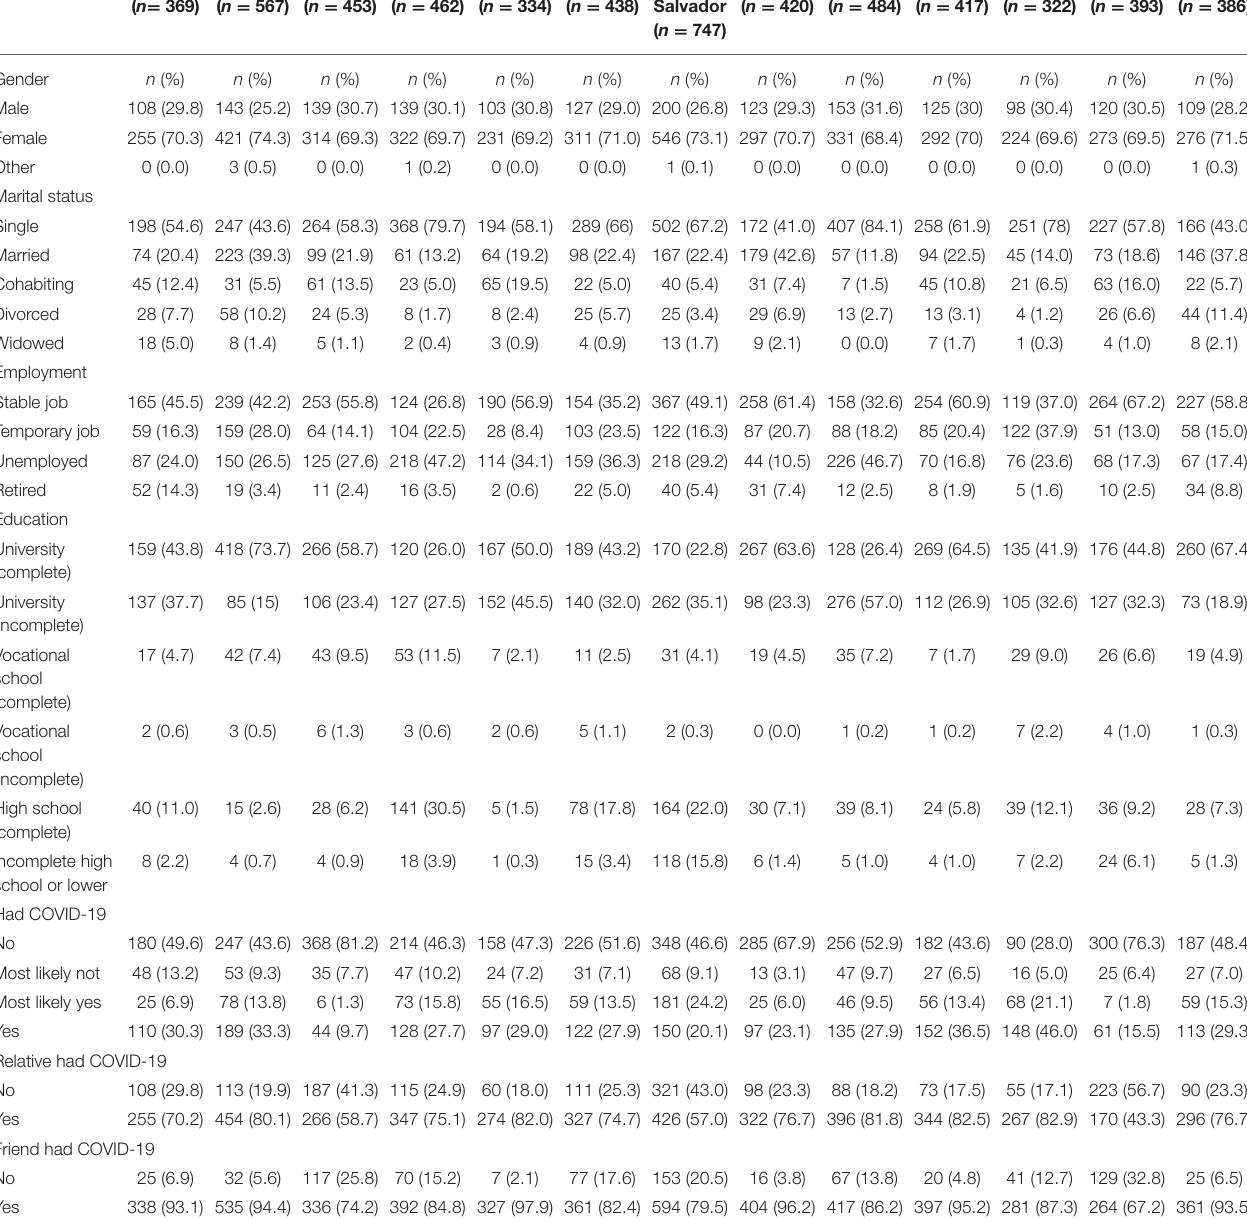
TABLE 1 | Sociodemographic Information of the Study Sample.